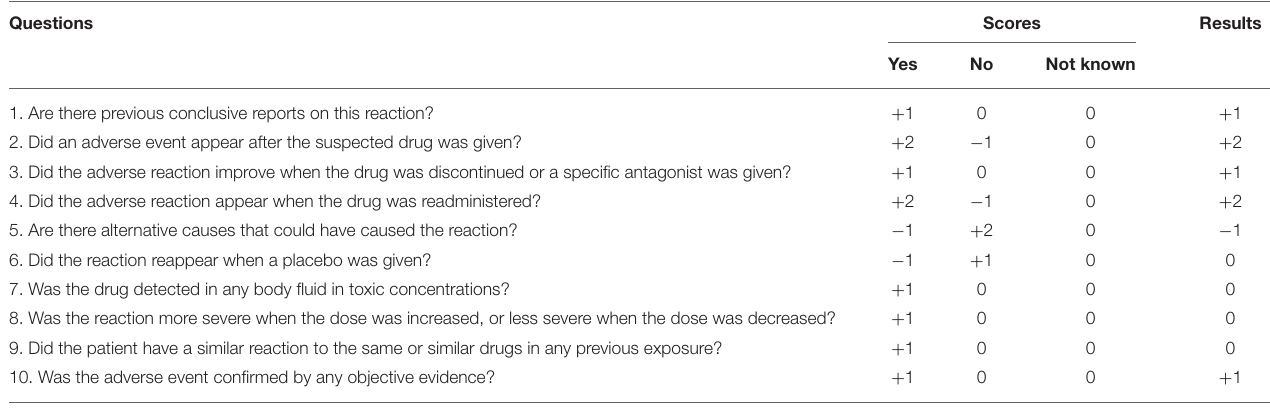
TABLE 2 | Naranjo adverse drug reaction probability scale.